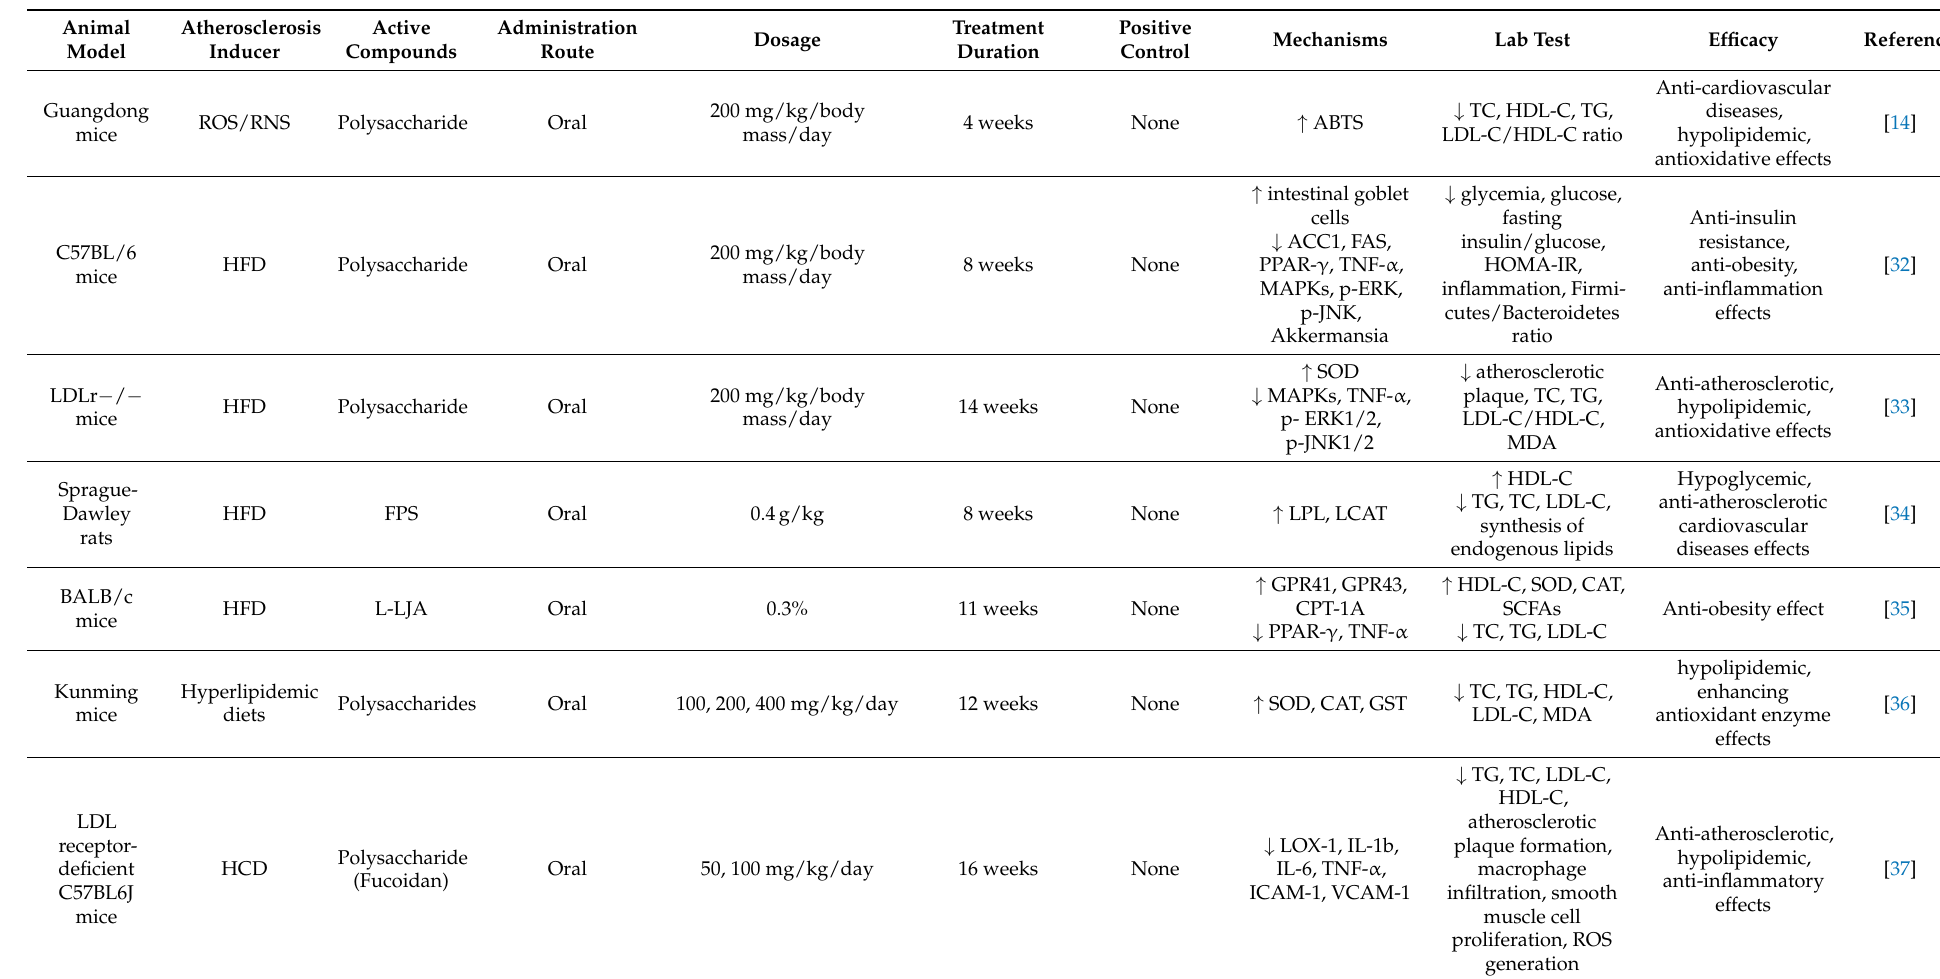
Table 3. An overview of the included in vivo studies on the efficacy of LJP on